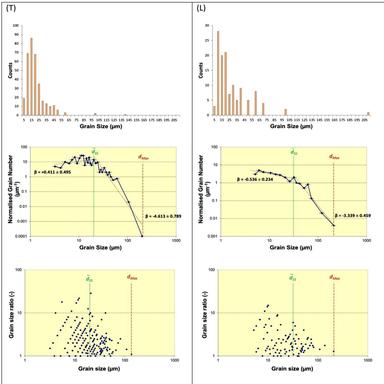
Grain size distribution plotted in lin DN/Ntot – lin , and, in log dN/dd – log d mode. A plot of Ri vs. grain size is also shown (bottom). The sample was recrystallised up to AGG at 1005°C, A, B and C transversal (T) from 1C, and, D, E and F longitudinal (L) from 1B, S = 233,700 mm2.